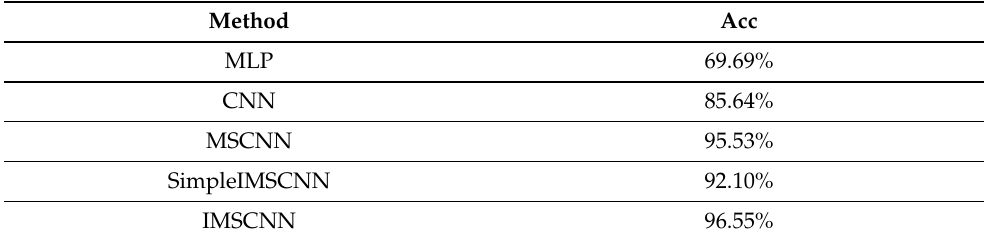
Table 8. The accuracy of each method in PU data